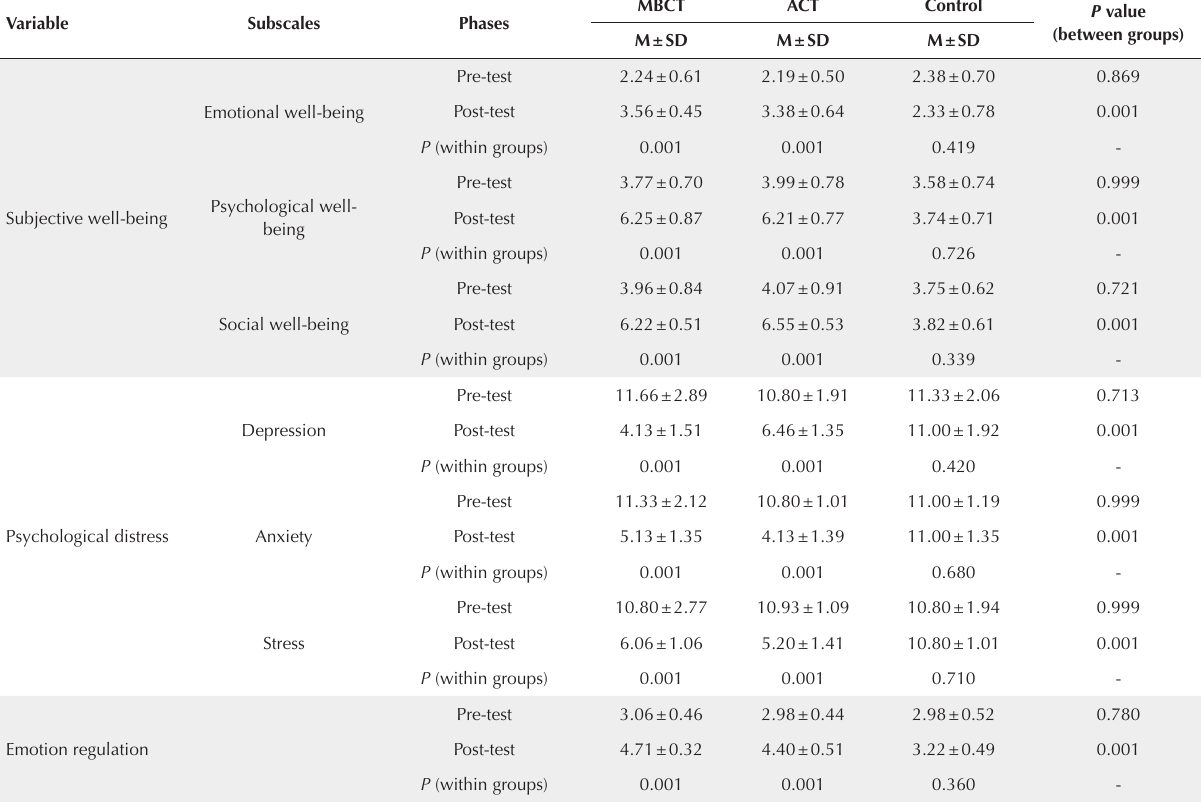
Table 3. Mean ± SD of research variables in experimental and control groups Variable